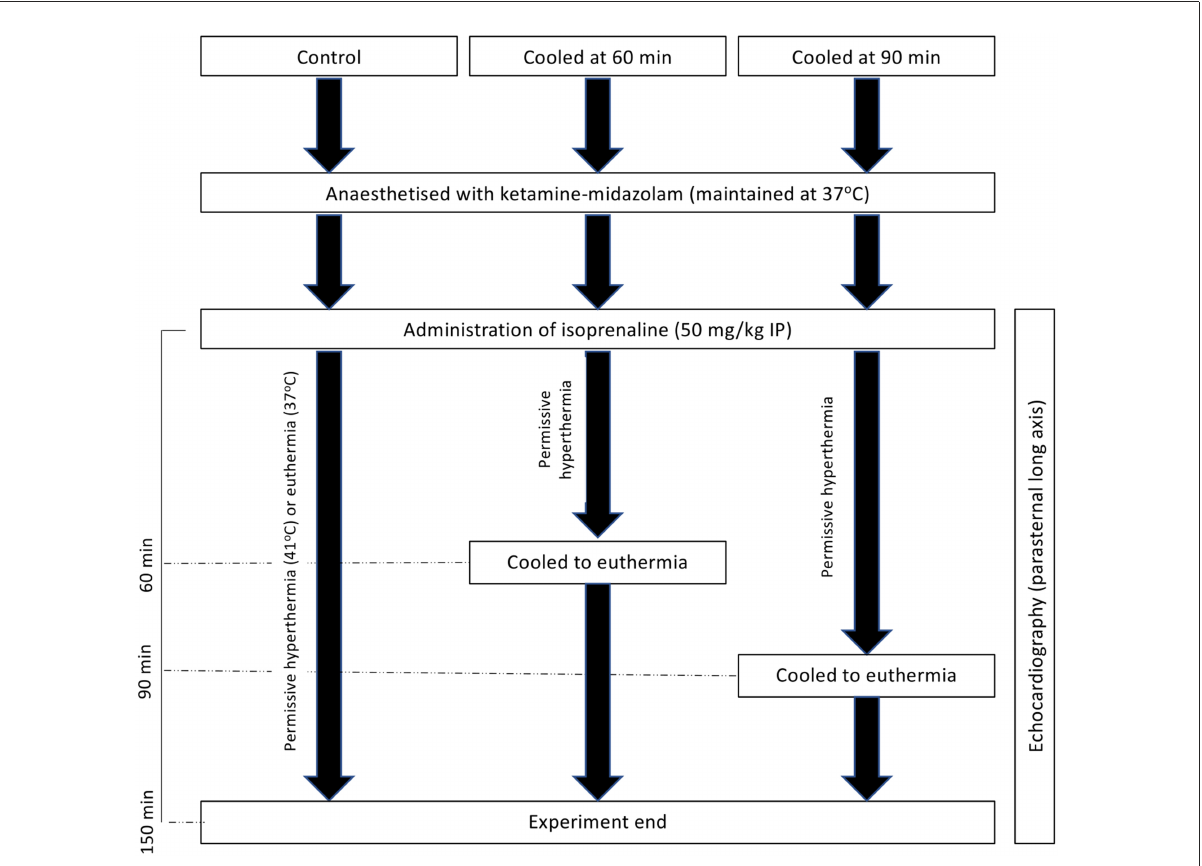
FIGURE1 Experimental schematic of hyperthermic experiments with and without cooling to 150min post-isoprenaline administration.